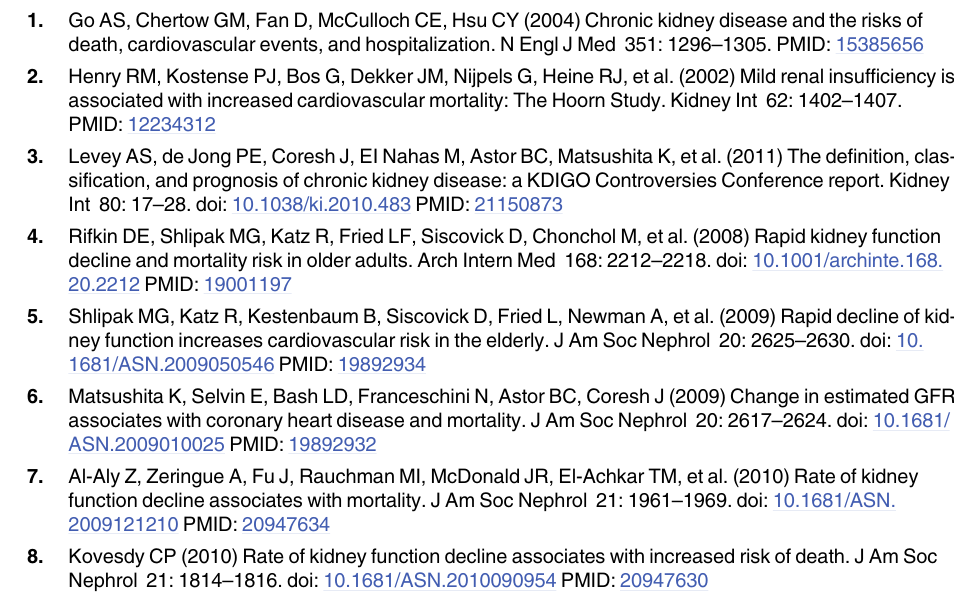
S11 Table. Slope (ml/min/1.73m 2 /year) of eGFR decline in healthy men with longer follow- up periods ( (cid:1) 4 years). Note: The statistical analysis in this table is the same as that used in Ta- bles 3 and 4. The mean (±SD) for intercept of eGFR was 79.7±11.1 ml/min/1.73m 2 in men with a longer follow-up period ( (cid:1) 4 years). S12 Table. Slope (ml/min/1.73m 2 /year) of eGFR decline in healthy women with shorter fol- low-up periods ( (cid:3) 2 years). Note: The statistical analysis in this table is the same as that used in Tables 3 and 4. The mean (±SD) for intercept of eGFR was 84.5±13.1 ml/min/1.73m 2 in women with a shorter follow-up period ( (cid:3) 2 years). S13 Table. Slope (ml/min/1.73m 2 /year) of eGFR decline in healthy women with longer fol- low-up periods ( (cid:1) 4 years). Note: The statistical analysis in this table is the same as that used in Tables 3 and 4. The mean (±SD) for intercept of eGFR was 82.5±11.9 ml/min/1.73m 2 in women with a longer follow-up period ( (cid:1) 4